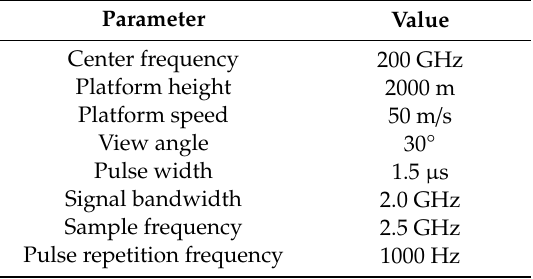
Table 1. System parameter table.